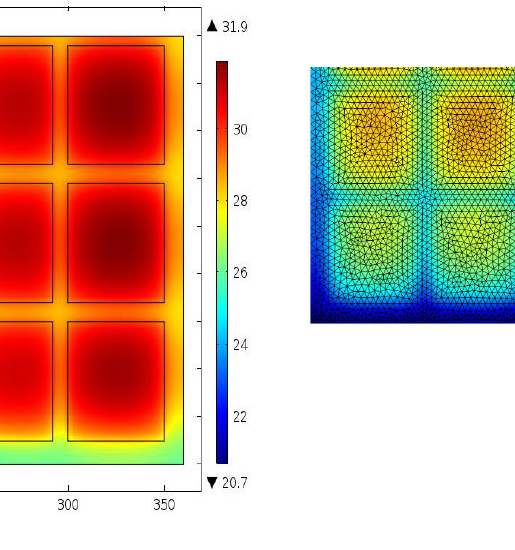
Figure 12. Original cold temperature surface within COMSOL.